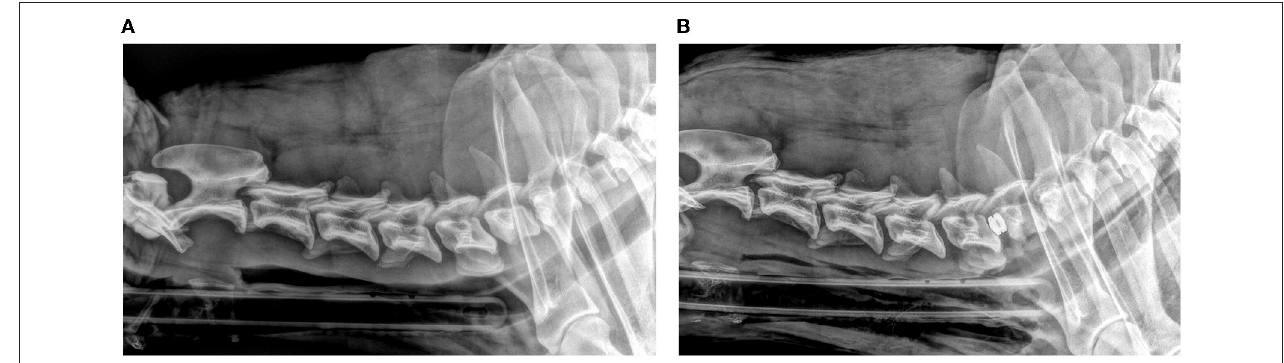
FIGURE 1 | Lateral pre-operative (A) and post-operative (B) radiographic views of a dog with prosthetic disc implantation.